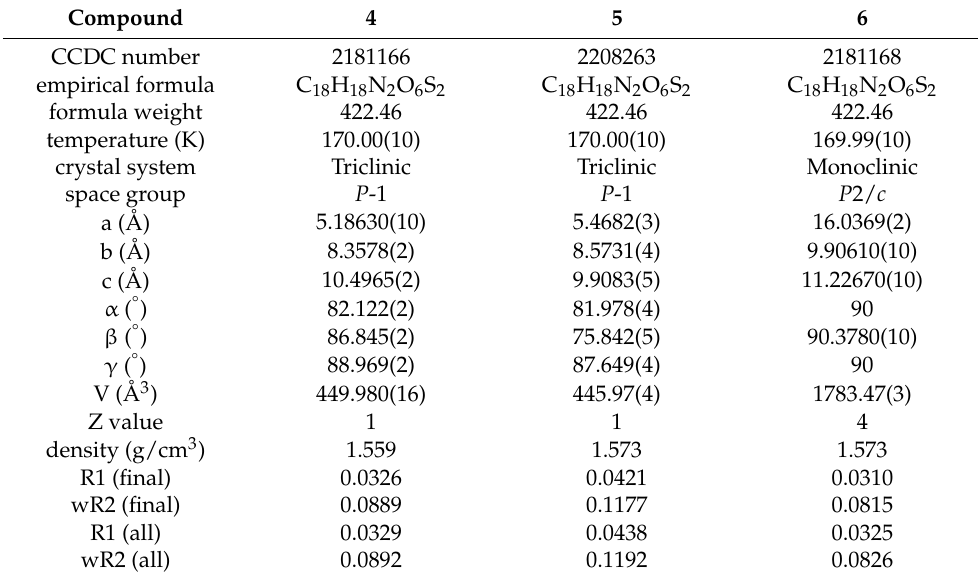
Table 1. Crystallographic data of 4 – 6